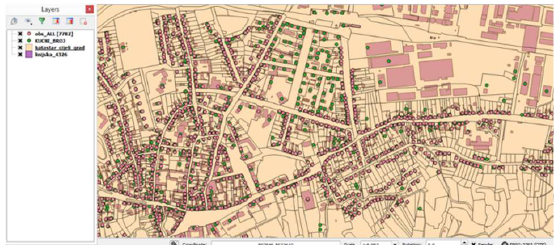
Figure 4. Integration of field observations with objects’ features from LM dataset in